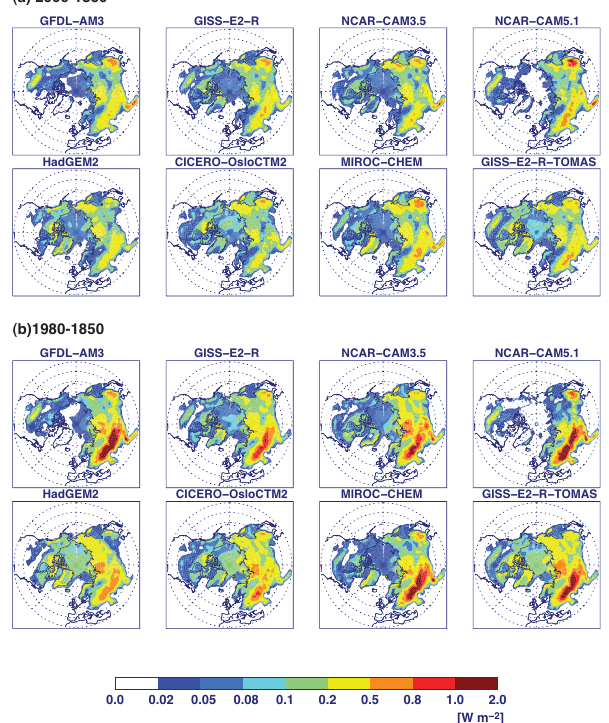
Fig. 16. Global distributions of the offline BC albedo forcing in (a) 2000 relative to 1850 and (b) 1980 relative to